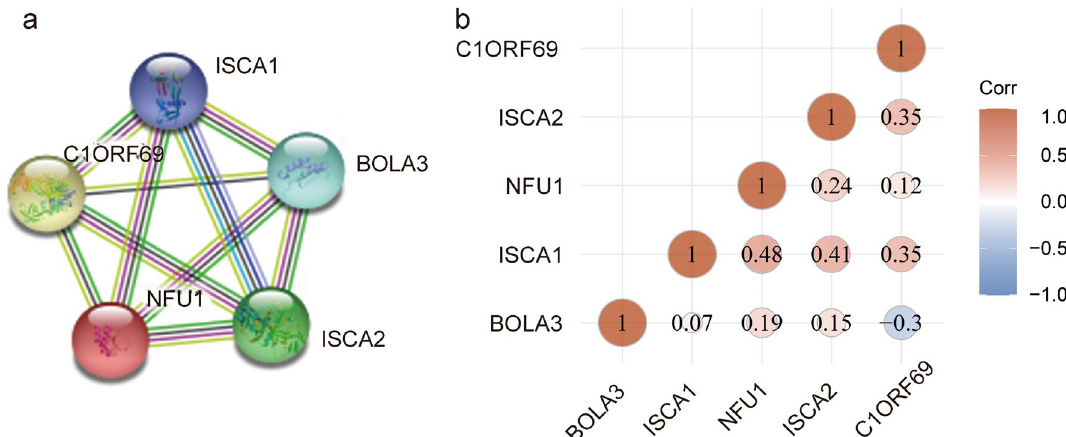
Figure 1. Correlation of the MMDS-related iron–sulfur protein gene and its expression with prognostic value in cancer. ( a ) PPI network. ( b ) Correlations of different iron–sulfur protein genes with each other in KIRC (Draw by the website tool: clinical bioinformatics (https:// www. aclbi. com/ static/ index.